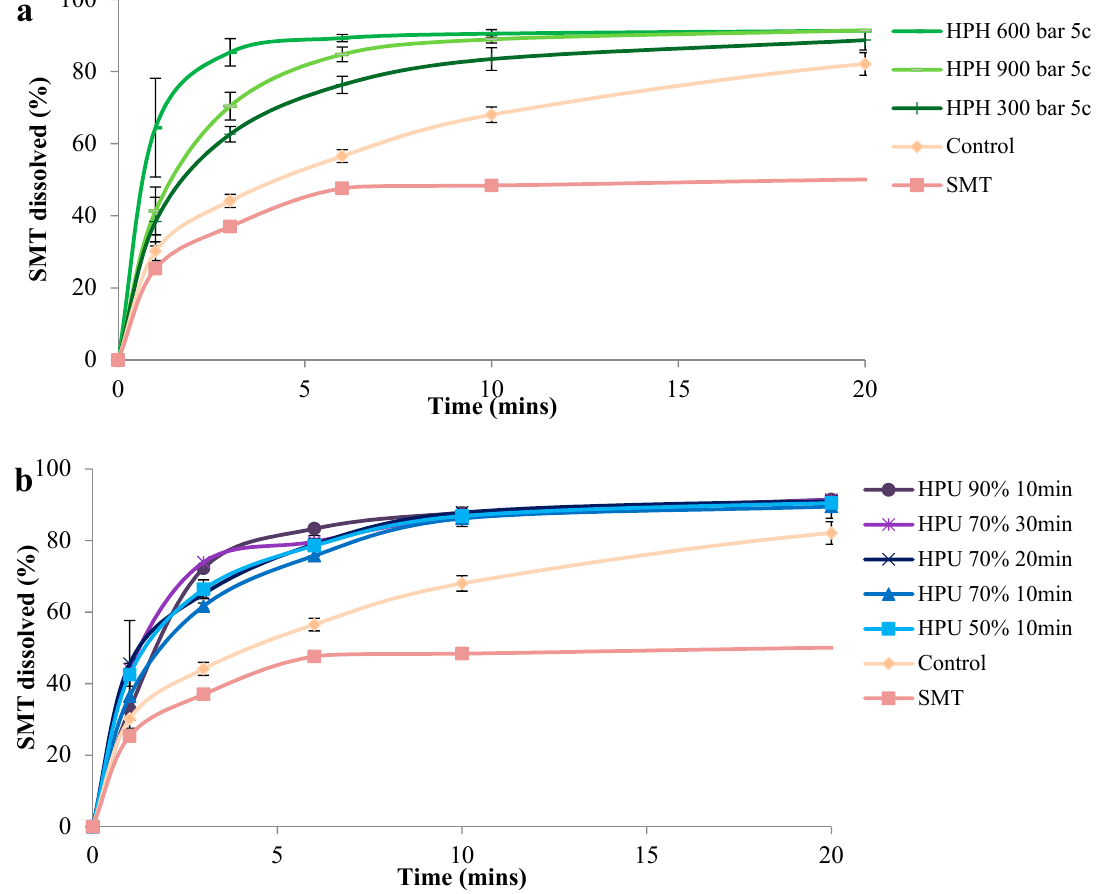
Figure 5. SMT dissolution profiles of the cocrystals. ( a ) Cocrystals prepared by HPH and ( b ) cocrystals prepared by HPU. HPH: high pressure-homogenization; HPU: high-power ultrasound; c: number of HPH cycles; percentage refers to HPU amplitude.